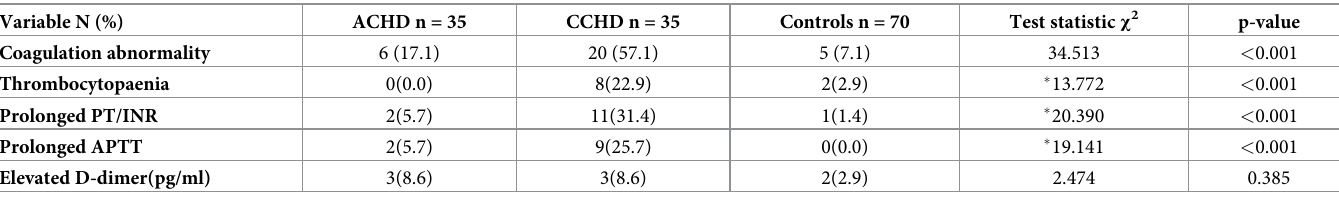
Table 4. Coagulation abnormalities in children with ACHD and CCHD.